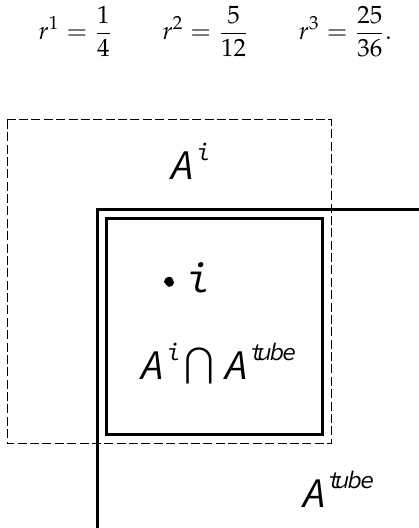
Figure 15. The overlap r i is defined as the area (small square) common to a tube cross section centered at the origin of type i (dashed line) and the tube cross section (solid line), divided by the complete tube cross